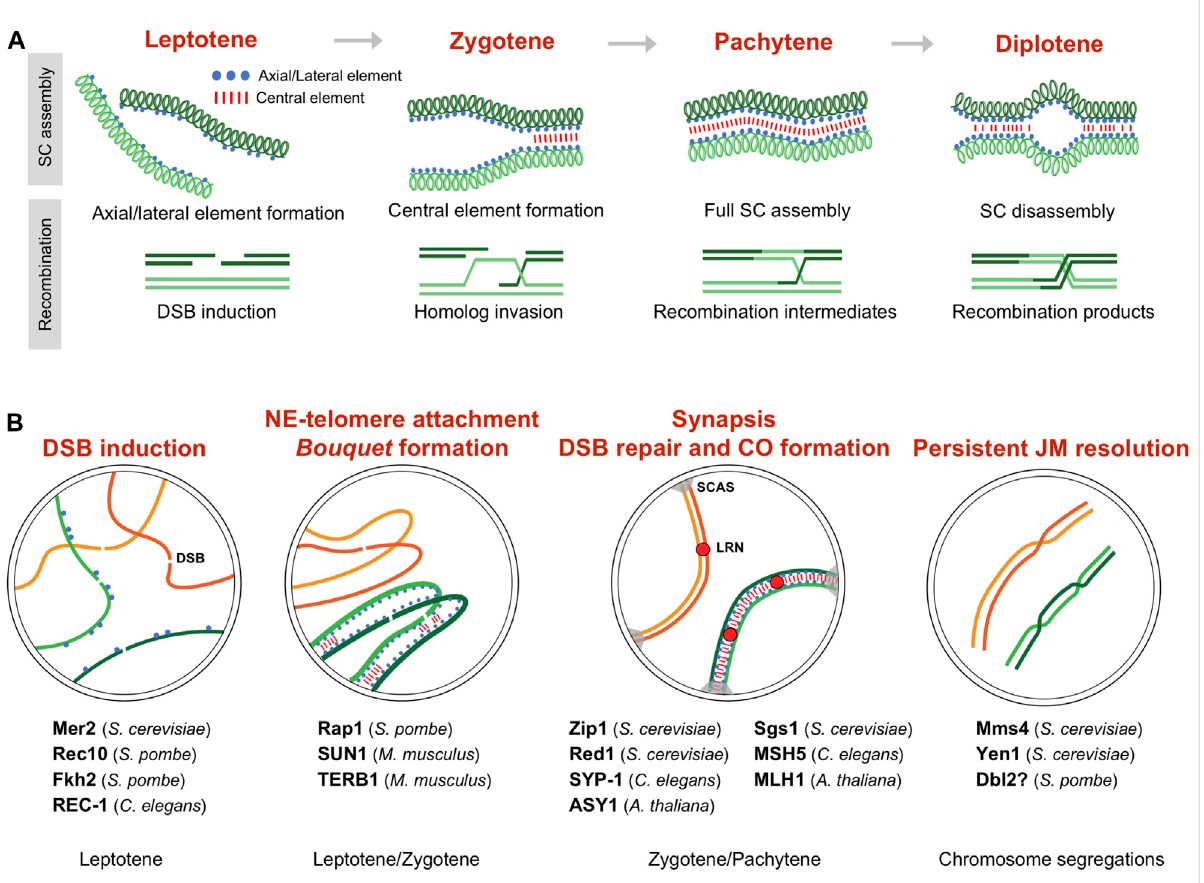
FIGURE 1 Meiotic prophase and CDK activity. (A) Synaptonemal complex (SC) formation and recombination during meiotic prophase between a pair of homologous chromosomes. Prophase is divided in different stages depending on the SC assembly (upper scheme). Recombination occurs in the context of the SC (lower scheme), and, in some organisms, it is linked to SC formation; for simplicity only the chromatid pair involved in recombination is depicted. (B) Meiotic events regulated by CDK activity and substrates. The regulated processes during the different prophase stagesarehighlighted.Identi fi edsubstratesindicatingthespeciesarelisted.SCassemblyisshownonlyinonepairofhomologs(greencolored).DSB double-strand break, SCAS synaptonemal complex attachment sites, LRN late recombination